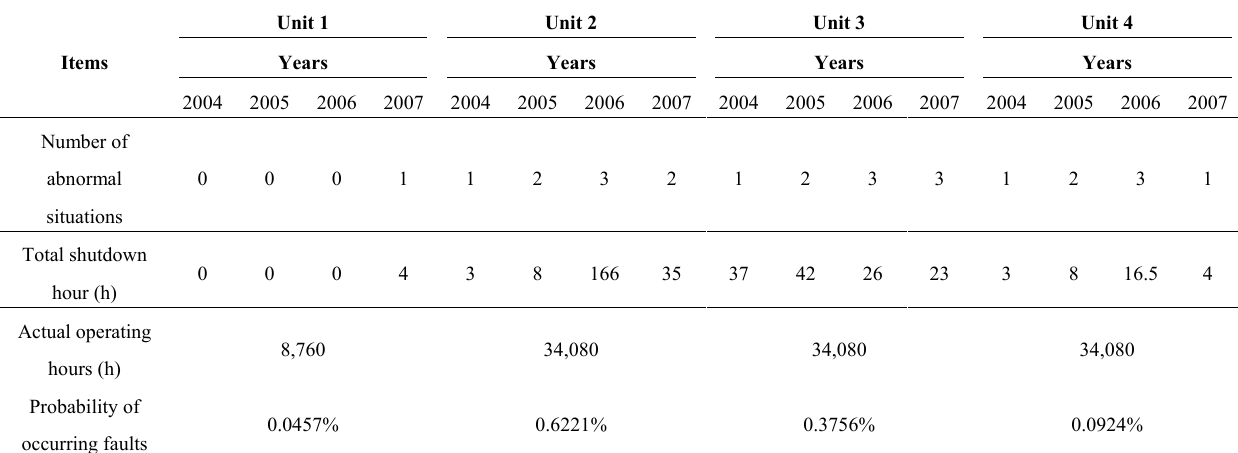
Table 11. Probability of the four in-plant boilers and steam turbines during the past four